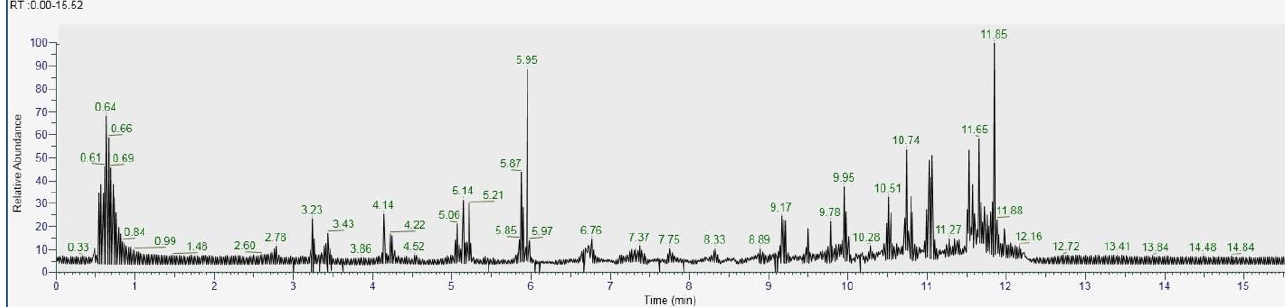
Figure 16. GC-MS/MS chromatogram of Coriolus versicolor. Table 1. GC-MS/MS analysis of Coriolus versicolor.